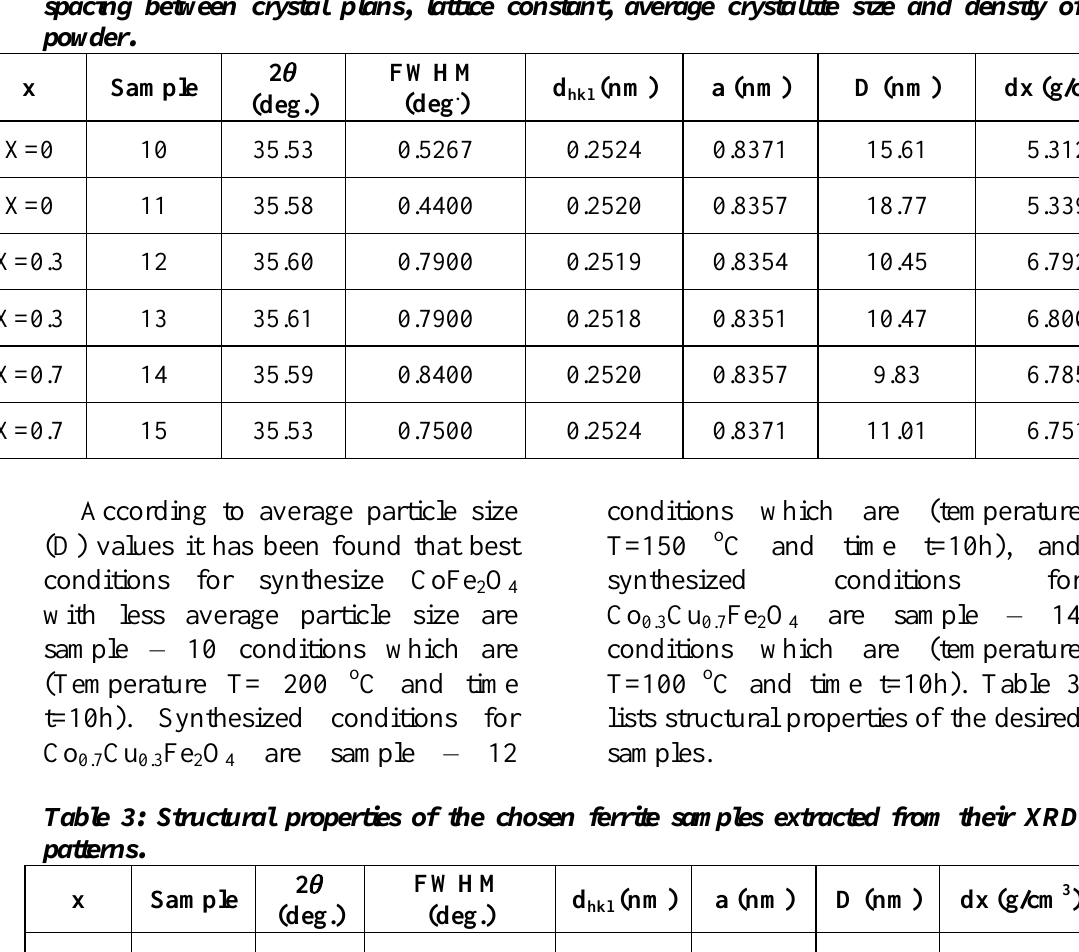
Cu Fe O ferrite samples. Experimental 1-x x 2 4